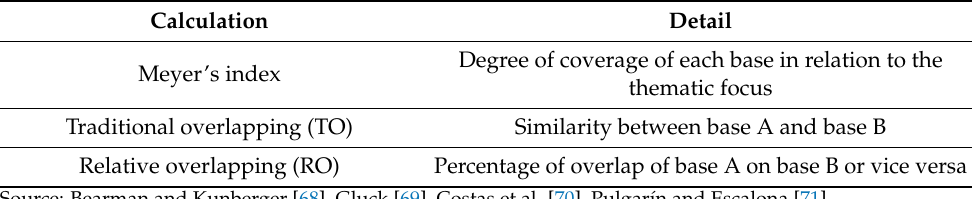
Table 3. Overlapping analysis.